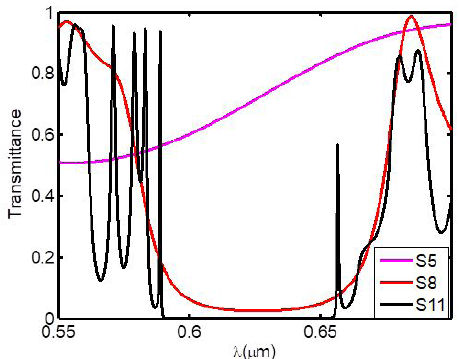
Figure 4. Transmittance spectra simulated on the quasi-periodic 1D PC structure with d2, d3, and T fixed at 0.1, 0.08 µm, and 100 K, respectively, while varying the number of Fibonacci sequence from 5 to 11.